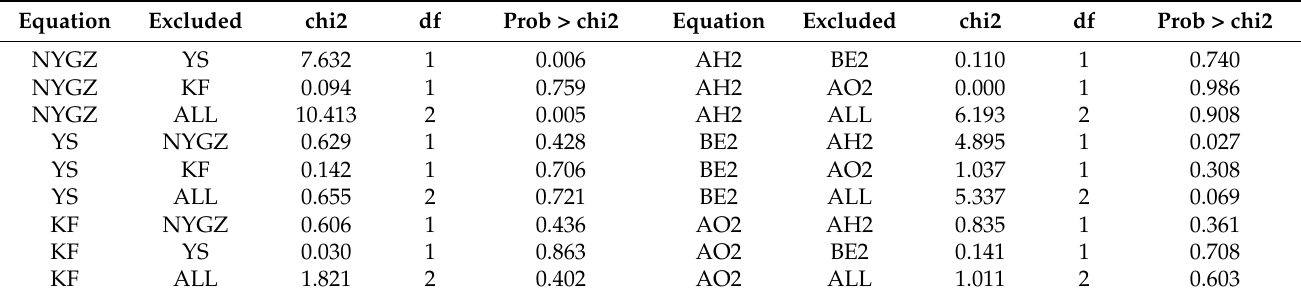
Table 6. PVAR–Granger causality Wald test.